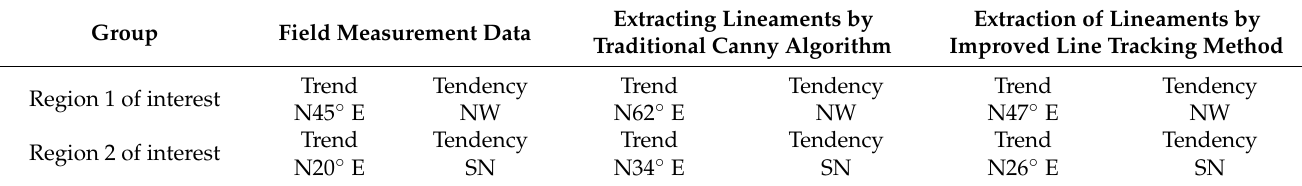
Table 3. Three sets of data for fracture strike and fracture